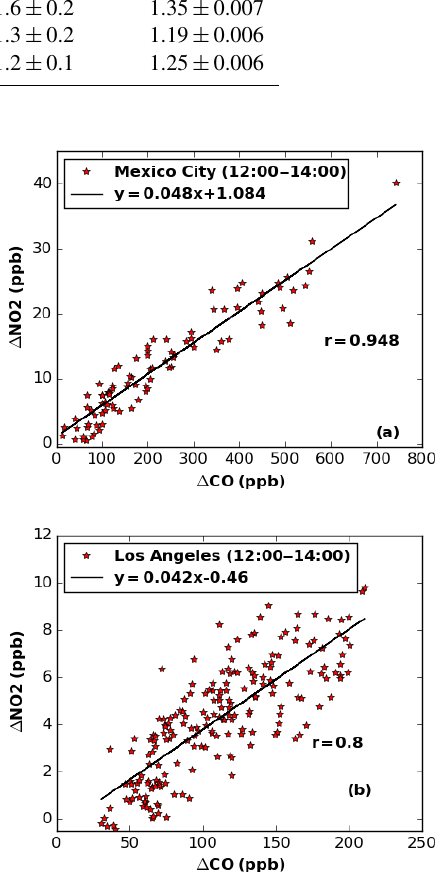
Figure 6. The relation between (cid:49) NO 2 and (cid:49) CO in surface mea- surements from Mexico (a) and Los Angeles (b) . The red dots rep- resent spatially averaged hourly measurements collected during the day (12:00 to